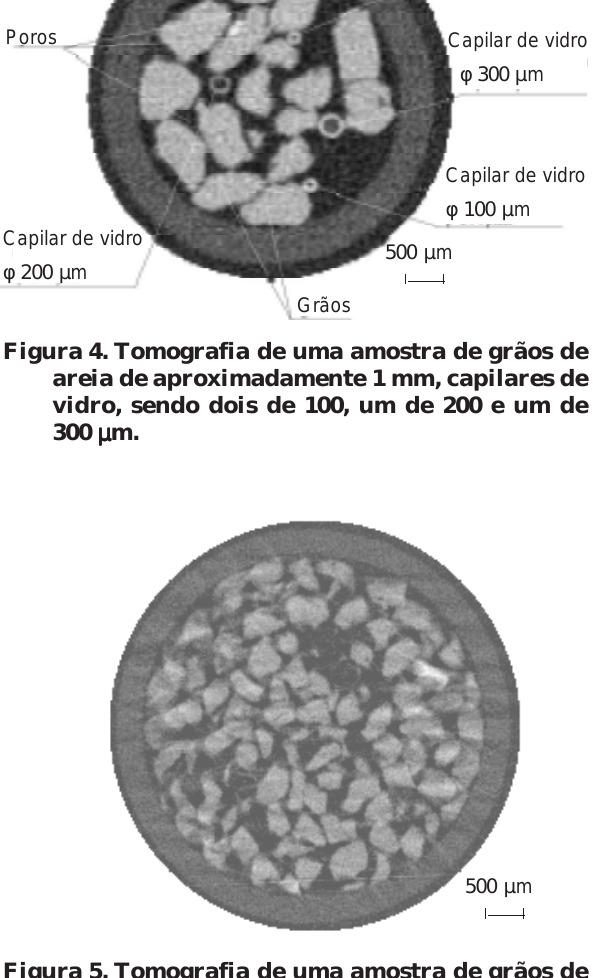
Figura 5. Tomografia de uma amostra de grãos de areia de 0,5 a 1 mm em recipiente com 10,81 mm de diâmetro interno.